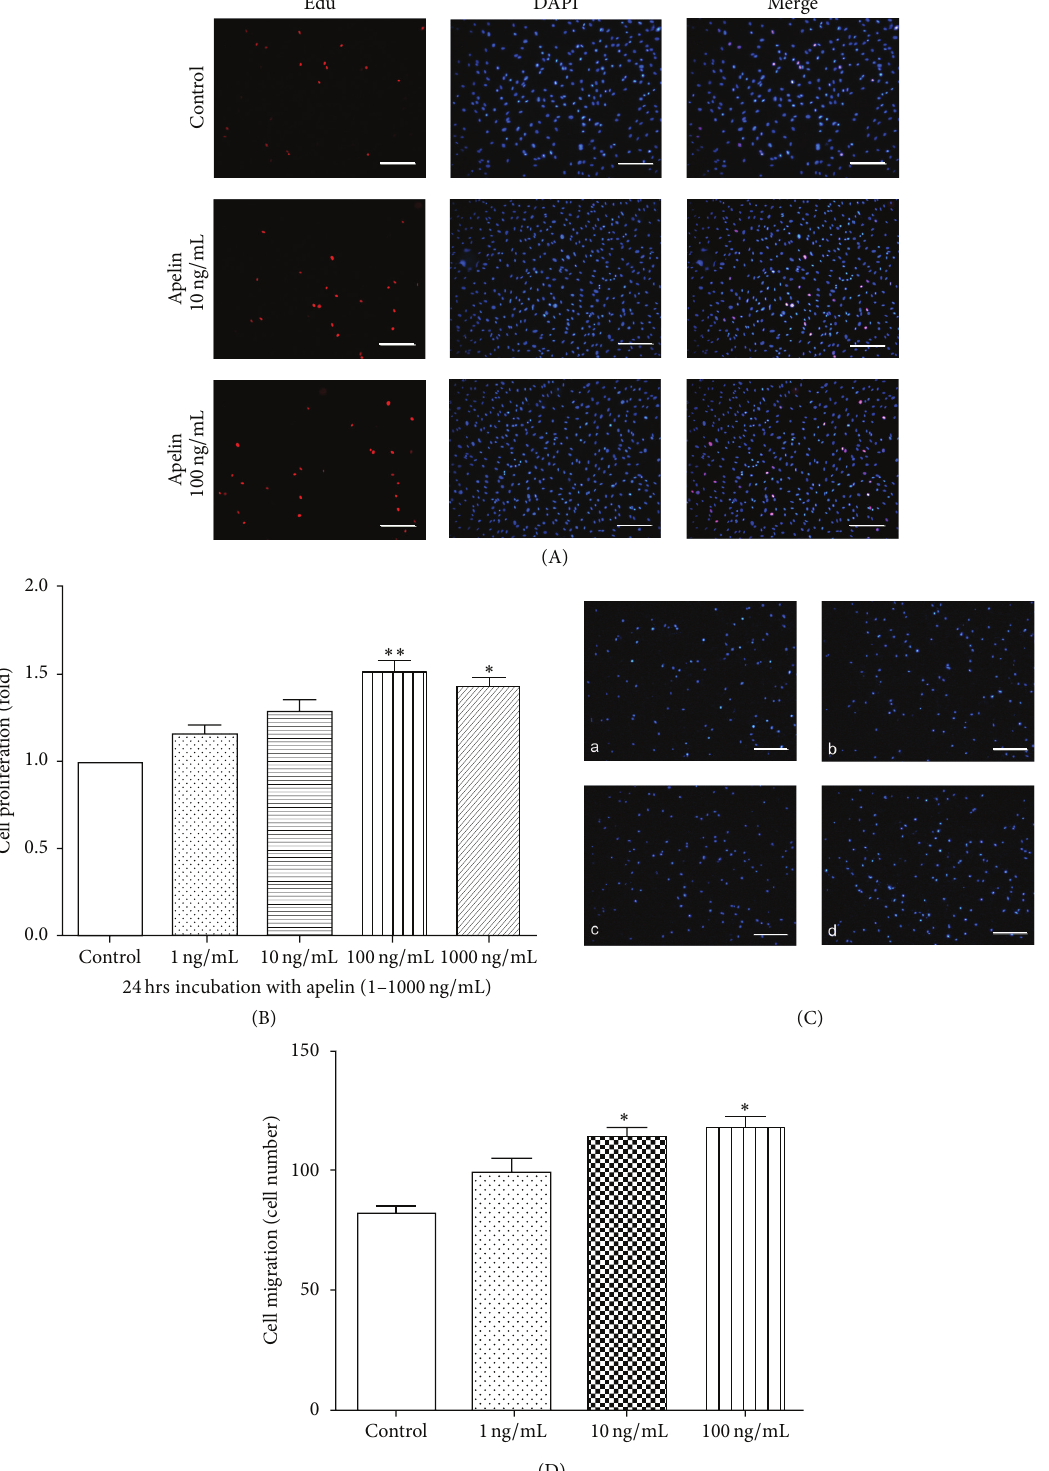
Figure 5: Effect of apelin on cell viability and migration under normoxia. (A) The Edu proliferation assay. Apollo staining (red) represents proliferating cells, and DAPI (blue) staining nuclei. Compared with the control group, the number of proliferating cells treated with apelin (10 or 100 ng/mL) increased significantly. Scale bar = 200 𝜇 m. (B) The folds of apelin-treated cell viability compared with the control group ( ∗ 𝑃 < 0.05 , ∗∗ 𝑃 < 0.01 versus untreated control); (C) and (D) pericyte migration in response to apelin treatment was measured using the transwell assay (a: control; b: 1ng/mL; c: 10ng/mL; d: 100 ng/mL, ∗ 𝑃 < 0.05 versus untreated control). The data are expressed as means ± standard deviation (SD). Scale bar = 200 𝜇